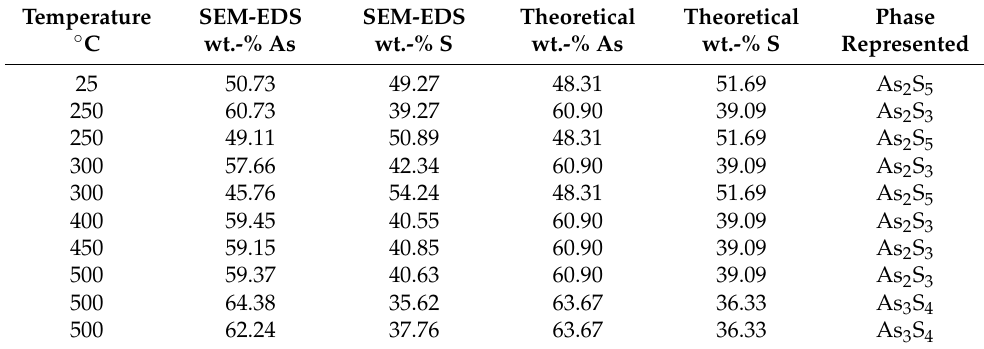
Table 3. Summary of SEM analysis of interrupted tests in an inert